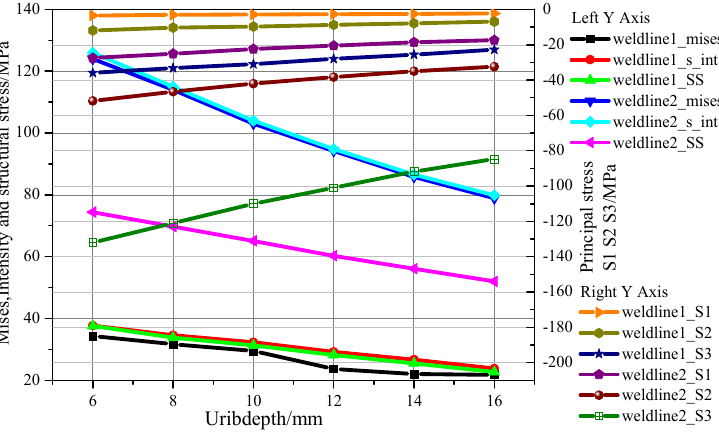
Figure 23. Trends of various stresses with the bridge deck thickness.